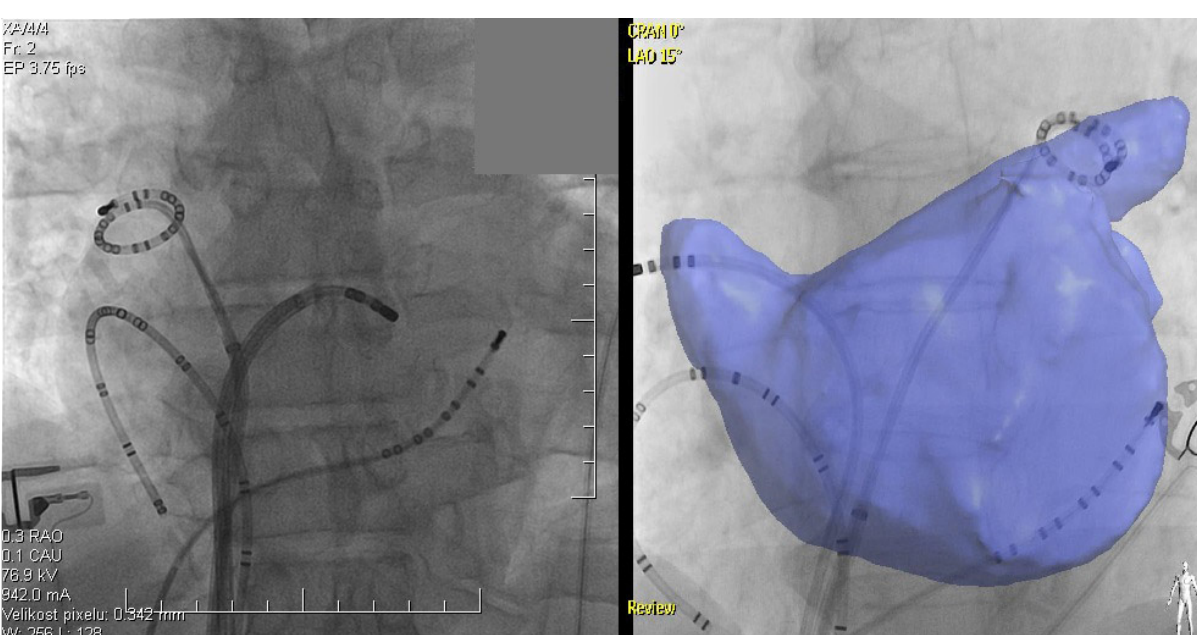
Fig. 1. On the left, there is a skiascopic view of catheter ablation of atrial fibrillation without using three-dimensional rotational angiography. On the right, there is a fused image of the skiascopic view and the 3D image of the left atrium obtained from three dimensional angiography. This fused image is great guidance for catheter ablation of atrial